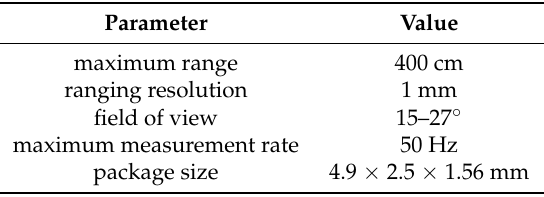
Table 1. Selected VL53L1X